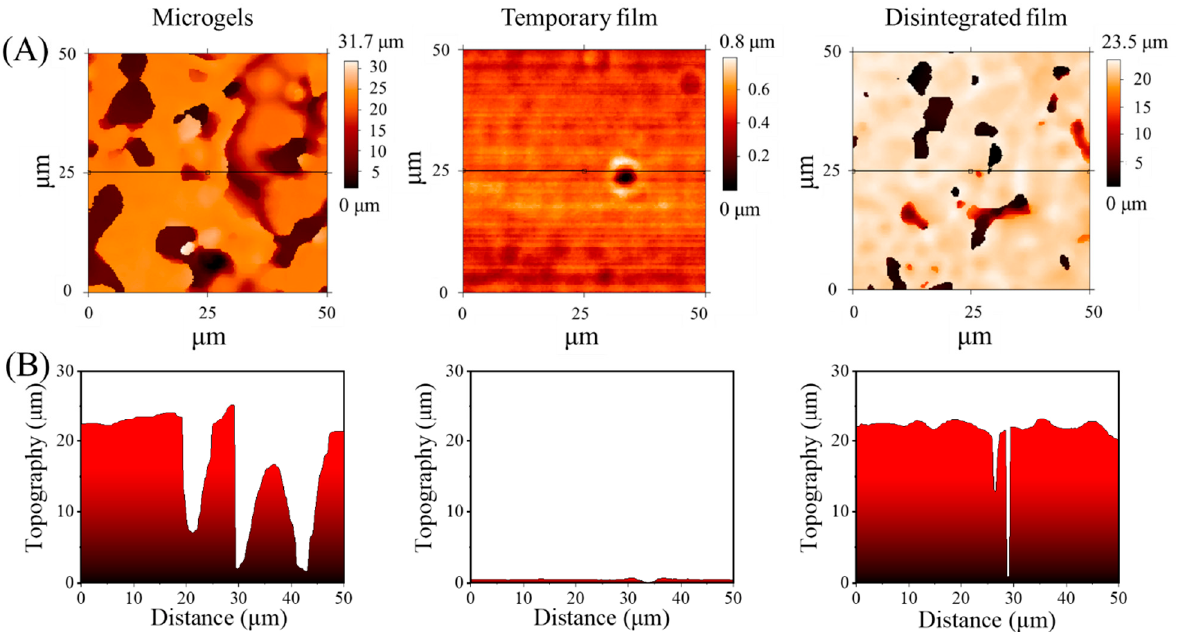
Figure 3. Representative surface profile ( A ) and height profile ( B ) of microgels with high deposition density, temporary film, and the disintegrated film obtained by optical profilometry.